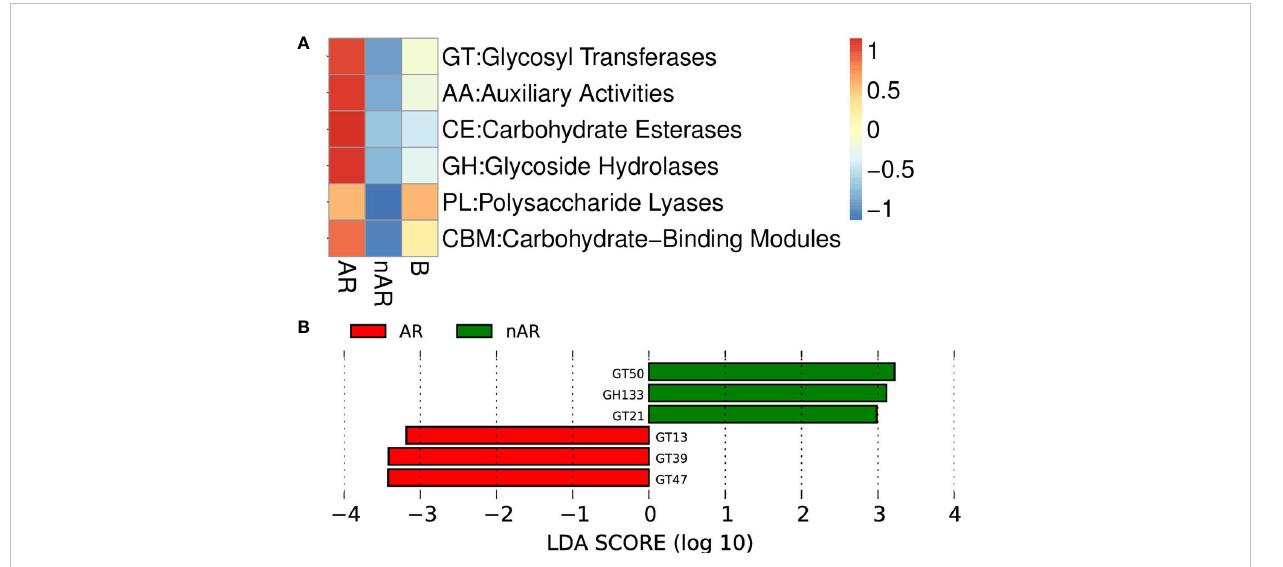
FIGURE 9 Differences between enzymes within the AR and nAR groups in the heat map (A) and LEfSe analysis (B) compared by CAZY